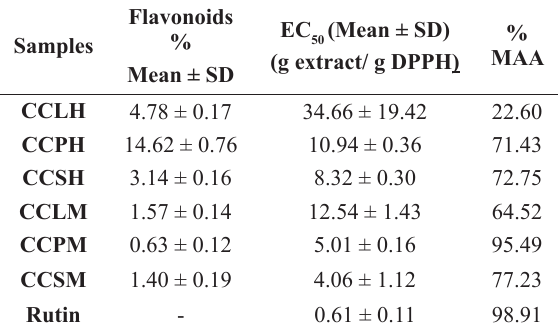
Content of total flavonoids (flavones and flavonols), EC and maximum antioxidant activity (MAA) of C. criuva